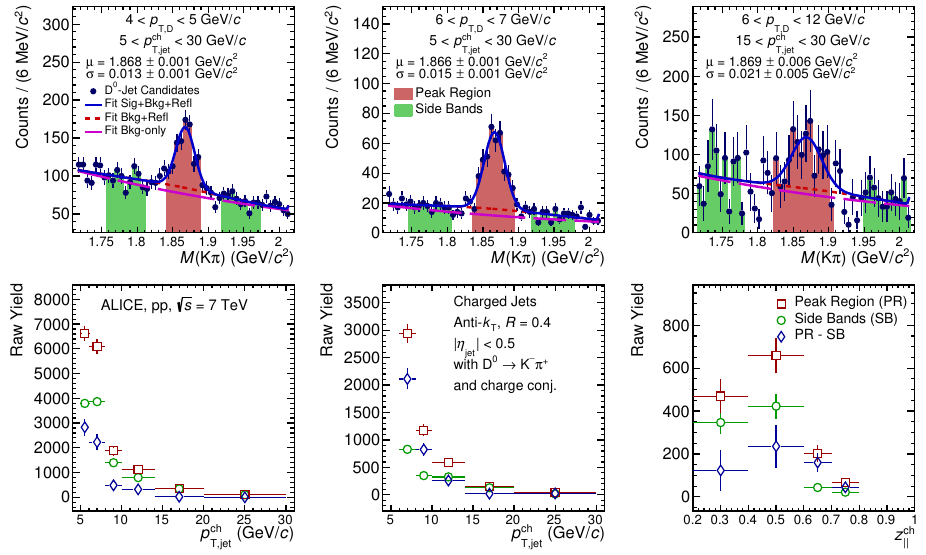
Figure 1 . Top: invariant mass distribution of D 0 -meson tagged jet candidates with 5 < p ch < T ; jet 30 GeV =c (left and center) and 15 < p ch < 30 GeV =c (right). The D 0 -meson transverse momenta T ; jet are required to be in the interval 4 < p T ; D < 5 GeV =c (left), 6 < p T ; D < 7 GeV =c (center) and 6 < p T ; D < 12 GeV =c (right). The blue solid line represents the total (cid:12)t function; the background component of the (cid:12)t function is shown with and without the re(cid:13)ection component, as a red dotted line and as a magenta dashed line, respectively. The green and red (cid:12)lled areas correspond to the side-band and peak regions. Bottom: distributions of the D 0 -meson tagged jet candidates in the peak region (red squares) and the side-band region (green circles) as a function of p ch (left and T ; jet center) and z ch (right). The p ch and p T ; D selections are the same as the corresponding top panels. T ; jet jj The blue diamonds show the subtracted distributions corresponding to the raw